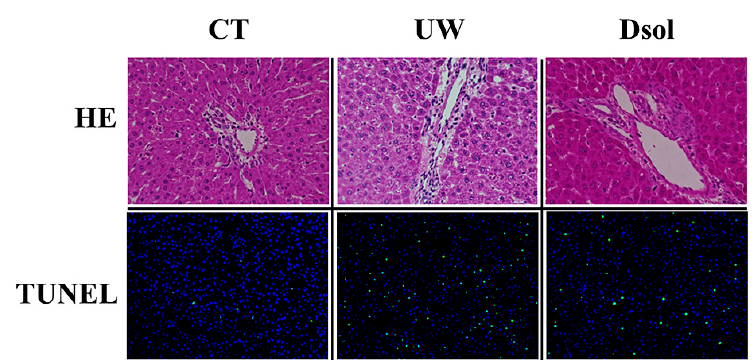
Figure 1. Dsol ameliorates histopathology. H&E staining (20 × and 40 × magnifications) showed almost normal appearance in the CT group. Vacuolization was shown in the UW group, whereas it was suppressed in the Dsol group. TdT-mediated dUTP nick end labeling (TUNEL)-positive cells were observed in the UW group, whereas they were hardly shown in the CT and Dsol groups.